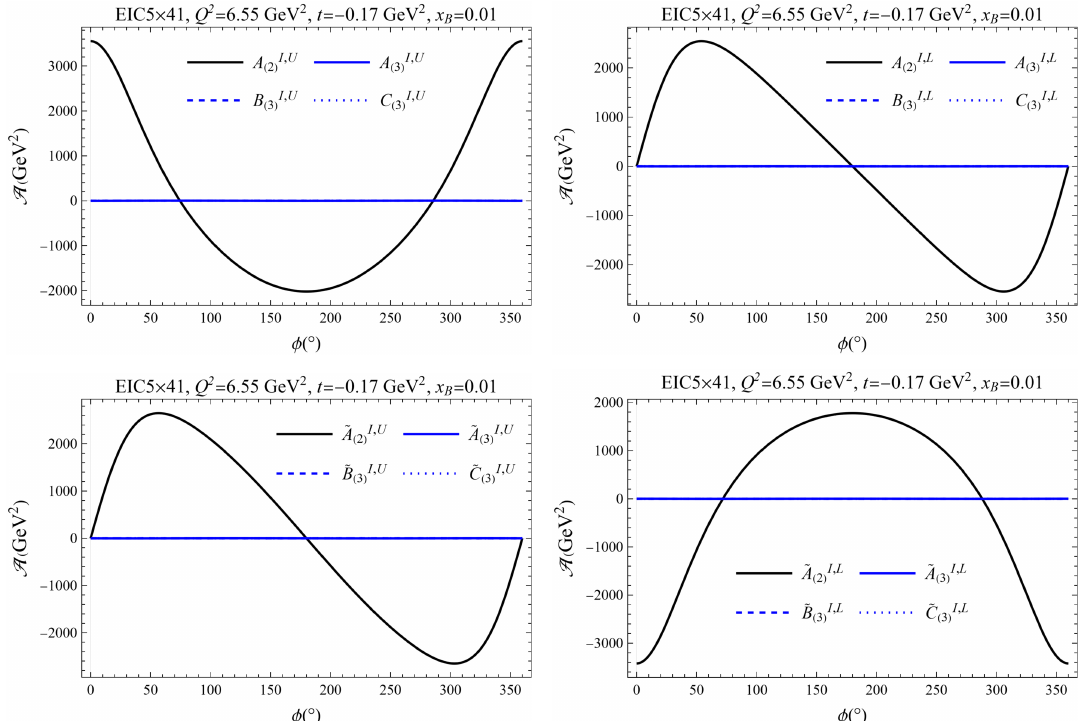
with A = { A, B, C, e A, e B, e C } for (3) and (2)